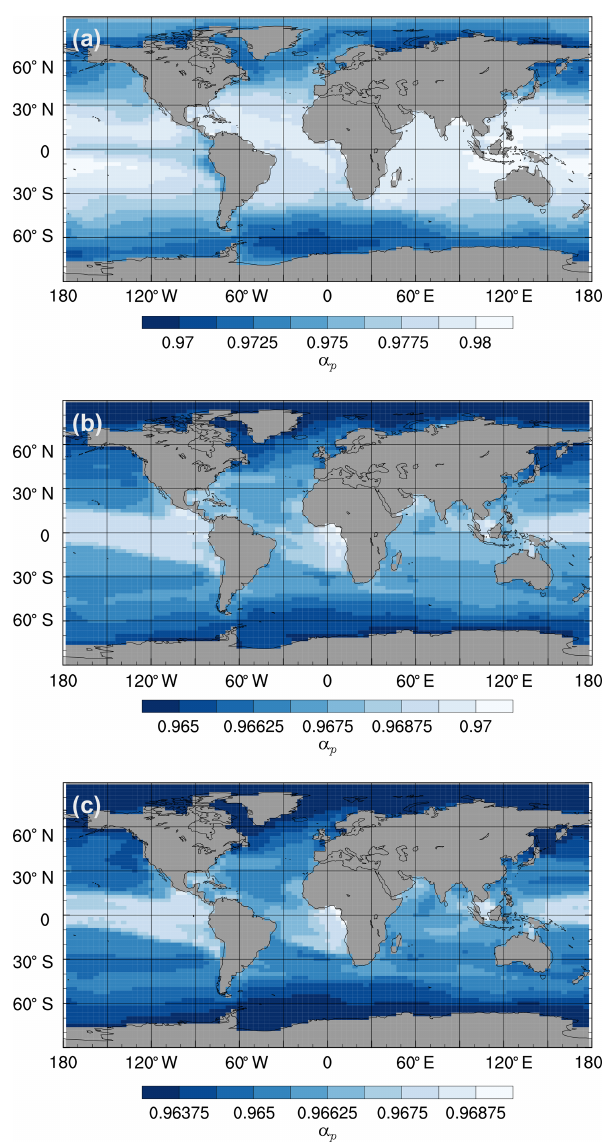
Figure 11. Mean annual isotopic fractionation during photosynthe- sis ( α p ) in the surface ocean at the end of the spin-up simulations (years 9900 to 10000): (a) the std simulation, (b) the L95 simula- tion, and (c) the L97